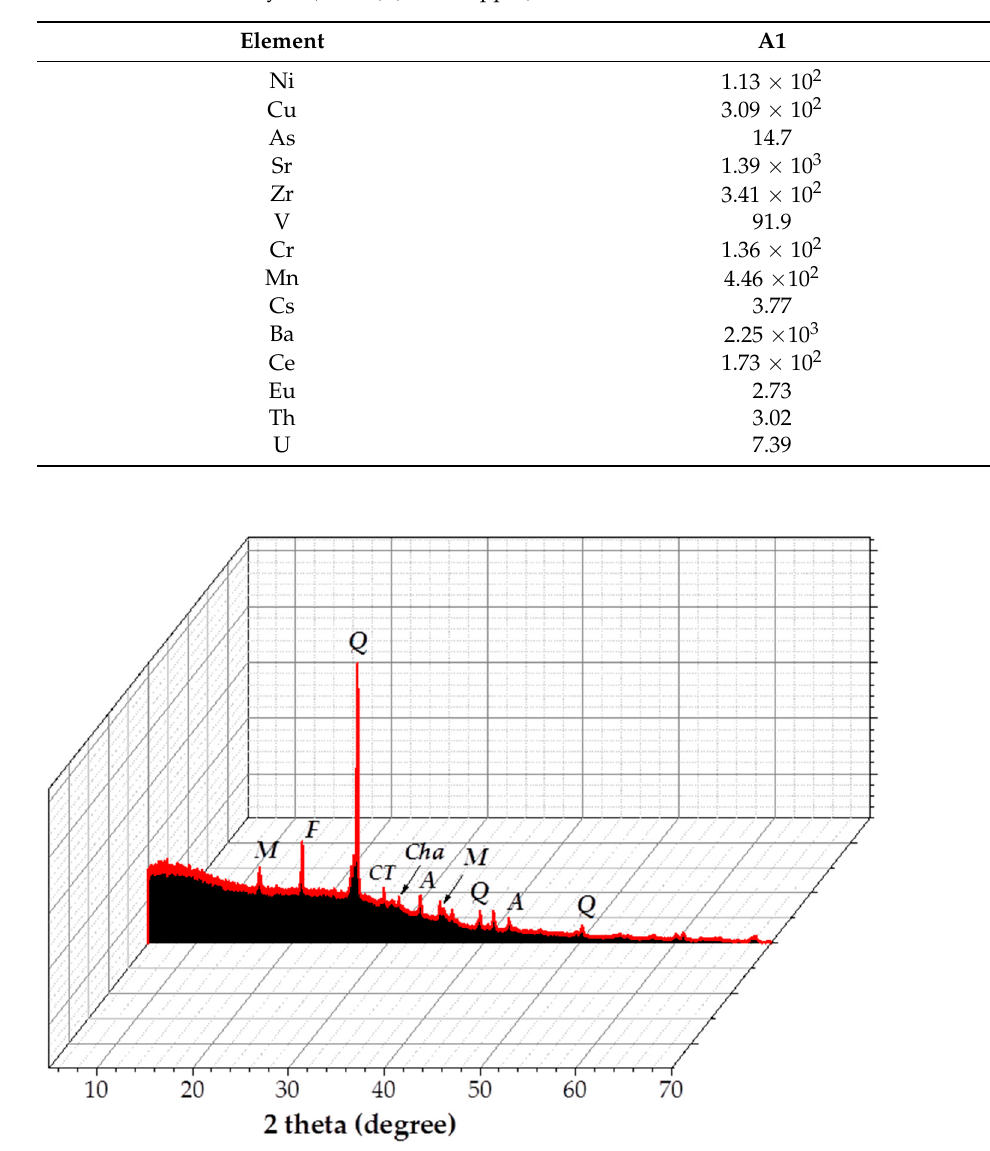
Table 3. The chemical composition of trace elements of the adsorbent as determined by instrumental neutron activation analysis (INAA) (mass in ppm).